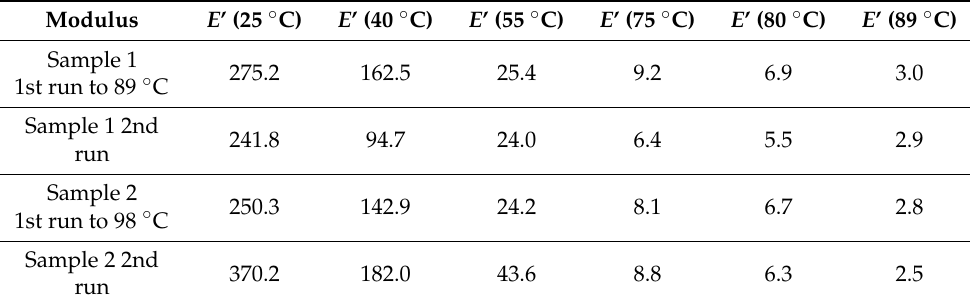
Figure 2. Storage modulus of the neat polymer. In the first run, samples were heated either to 89 ◦ C (Sample 1) or 98 ◦ C (Sample 2). Table 2. Storage modulus of the neat polymer at different temperatures. All values in